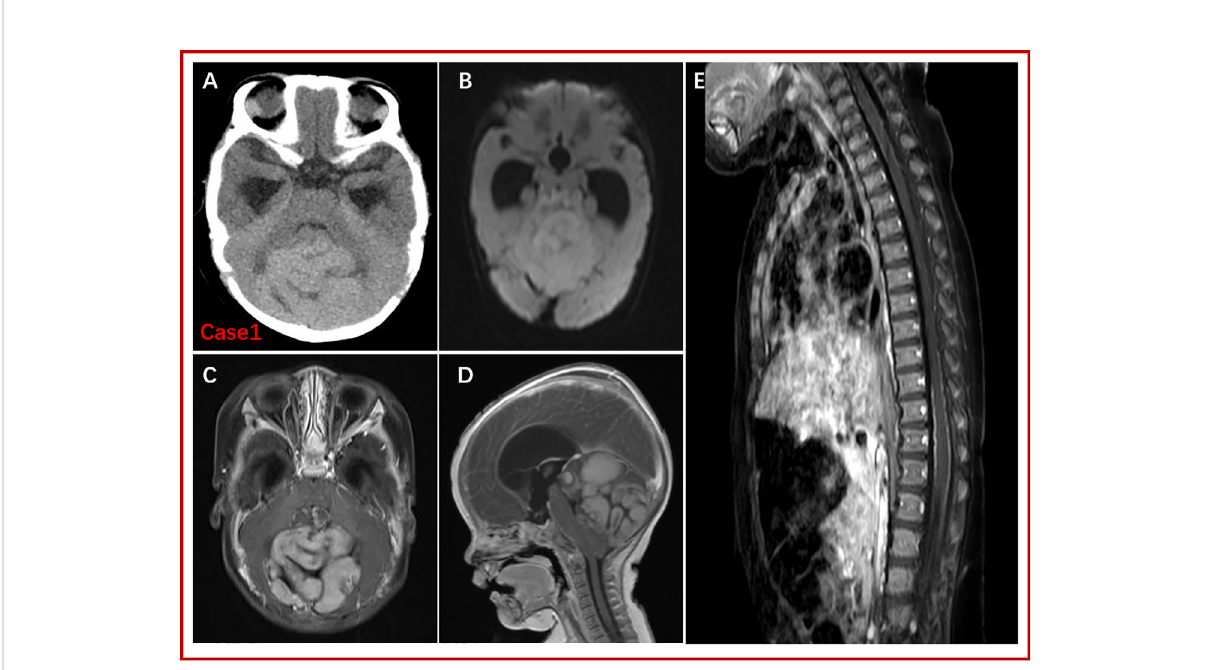
FIGURE 1 CT and MRI fi ndings for Patient one. A large abnormal signal mass (5.4 cm x 5.7 cm x 7.0 cm) was detected above the cerebellum in the posterior fossa, with poorly de fi ned borders. CT showed a slightly high-density mass shadow. T1WI revealed isointense or low signal, T2-FLAR isointense or slightly high signal, and DWI high signal. Enhanced scanning showed high heterogeneity (multiple nodules). There was no obvious abnormality regarding the spinal cord or morphological signals; the surface of the spinal cord was line-like, with small, strong nodular signals by enhanced scanning. (A) : Preoperative, noncontrast CT. (B) : DWI. (C) and (D) : Gd-enhanced T1W images. (E) : Gd-enhanced MRI of the spinal